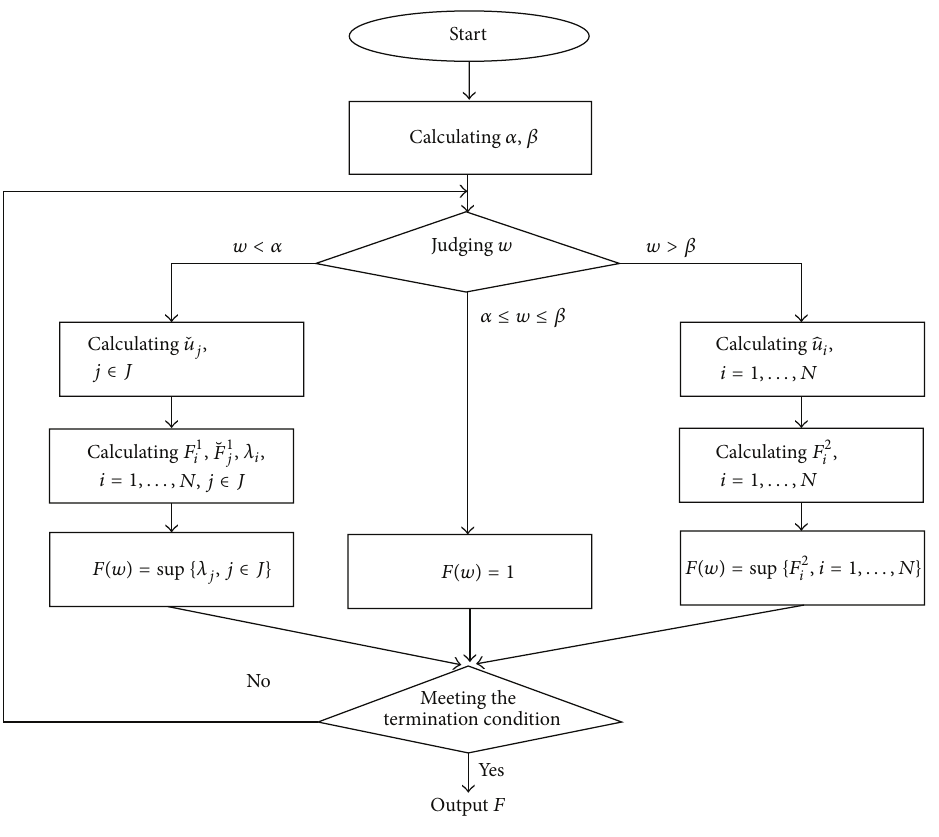
Figure 1: The structure of Algorithm